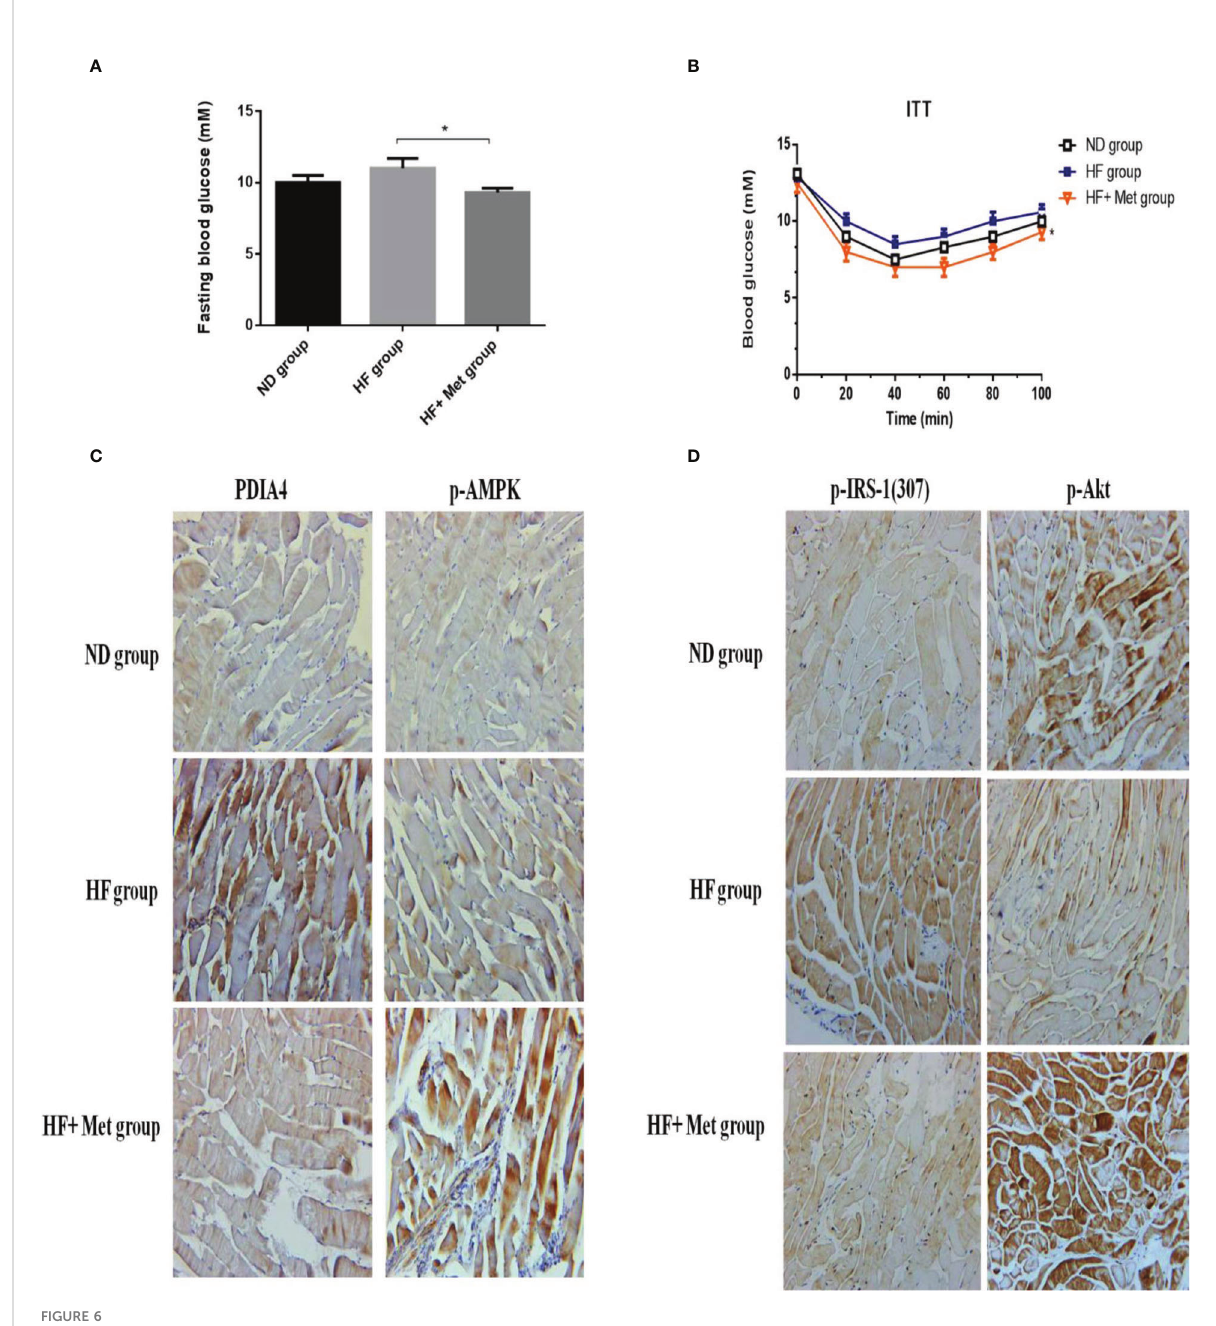
FIGURE 6 Metformin decreased PDIA4 and improved IR in high-fat diet induced obesity mice model. Administered metformin (200mg/kg) through intraperitoneal injection into high fat diet (HFD, 60% kcals from fat) induced obesity in C57BL6/J mice, and a chow diet (10% kcals from fat) as control group, and then examined (A, B) basal blood glucose, and insulin tolerance. (C, D) The mice soleus muscle tissues were examined PDIA4, P-AMPK, P-IRS-1(307), and P-Akt by immunohistochemistry, 20X. Representative data were shown from experiments independently performed at least three times. *P <